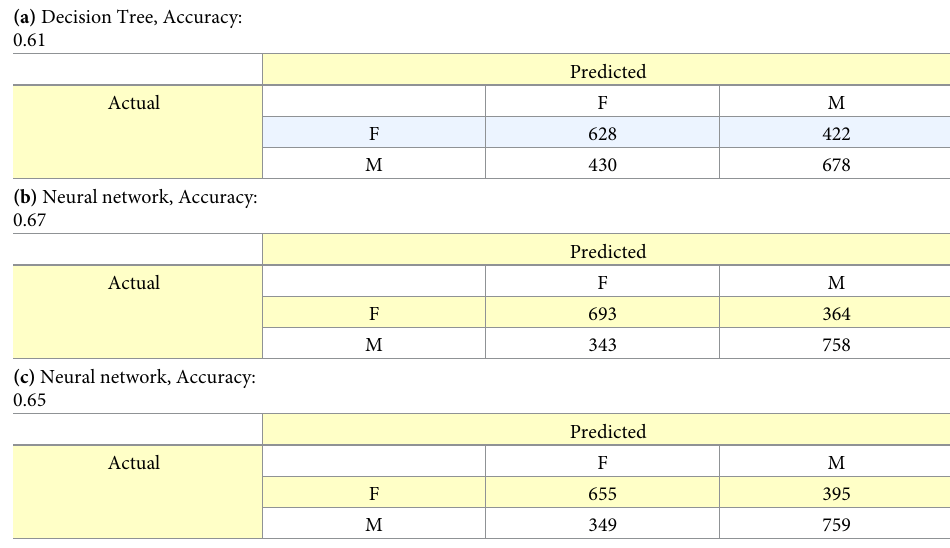
Table 6. Gender prediction confusion matrices (F: Female, M: Male). (a) Decision Tree, Accuracy: